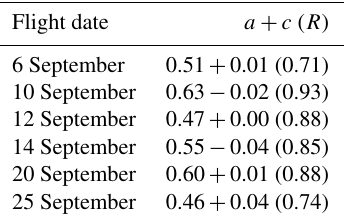
Table A1. ORACLES 2016 flight dates with the best-fit slope ( a ) and intercept ( c ) between the average CAS LWC and King LWC from the